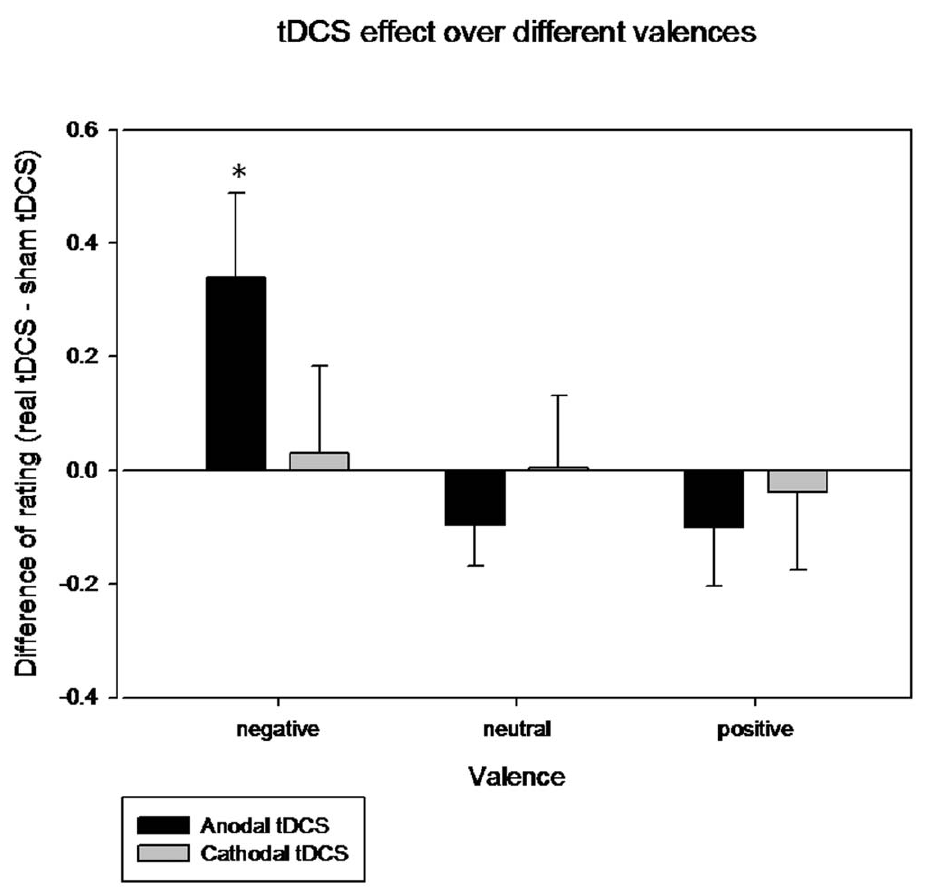
Figure 3. Changes induced by real tDCS in the scores of emotional evaluations compared to sham tDCS. The values correspond to the mean change of rating between sham and real tDCS (and standard errors of mean), both anodal and cathodal, for each valence category. Only ratings for the negative emotional pictures under anodal left DLPFC were significantly different from sham (* p=0.036, see table 3).